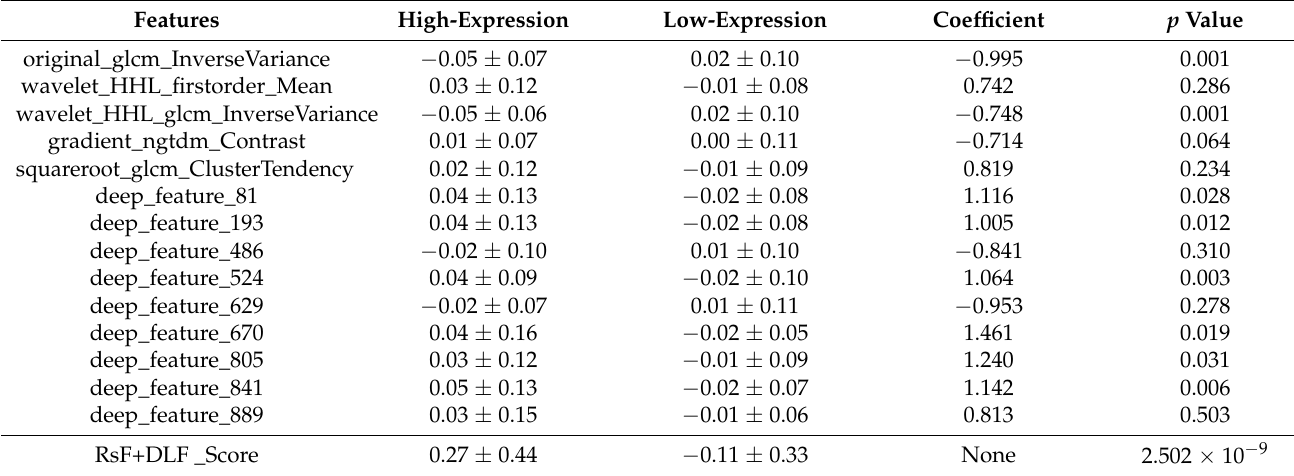
Table 4. Results of statistical analysis of integrated features selected.